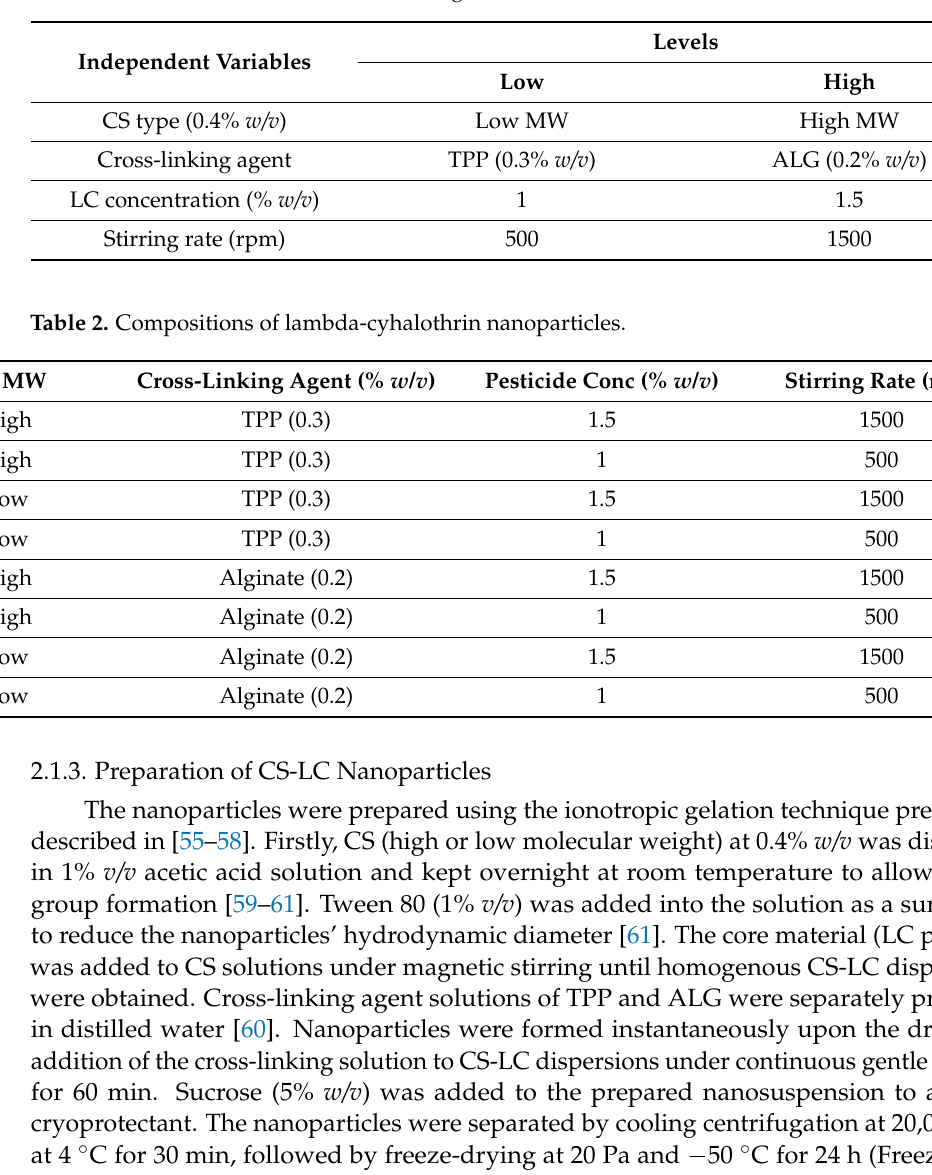
Table 1. Factors and levels of factorial design.